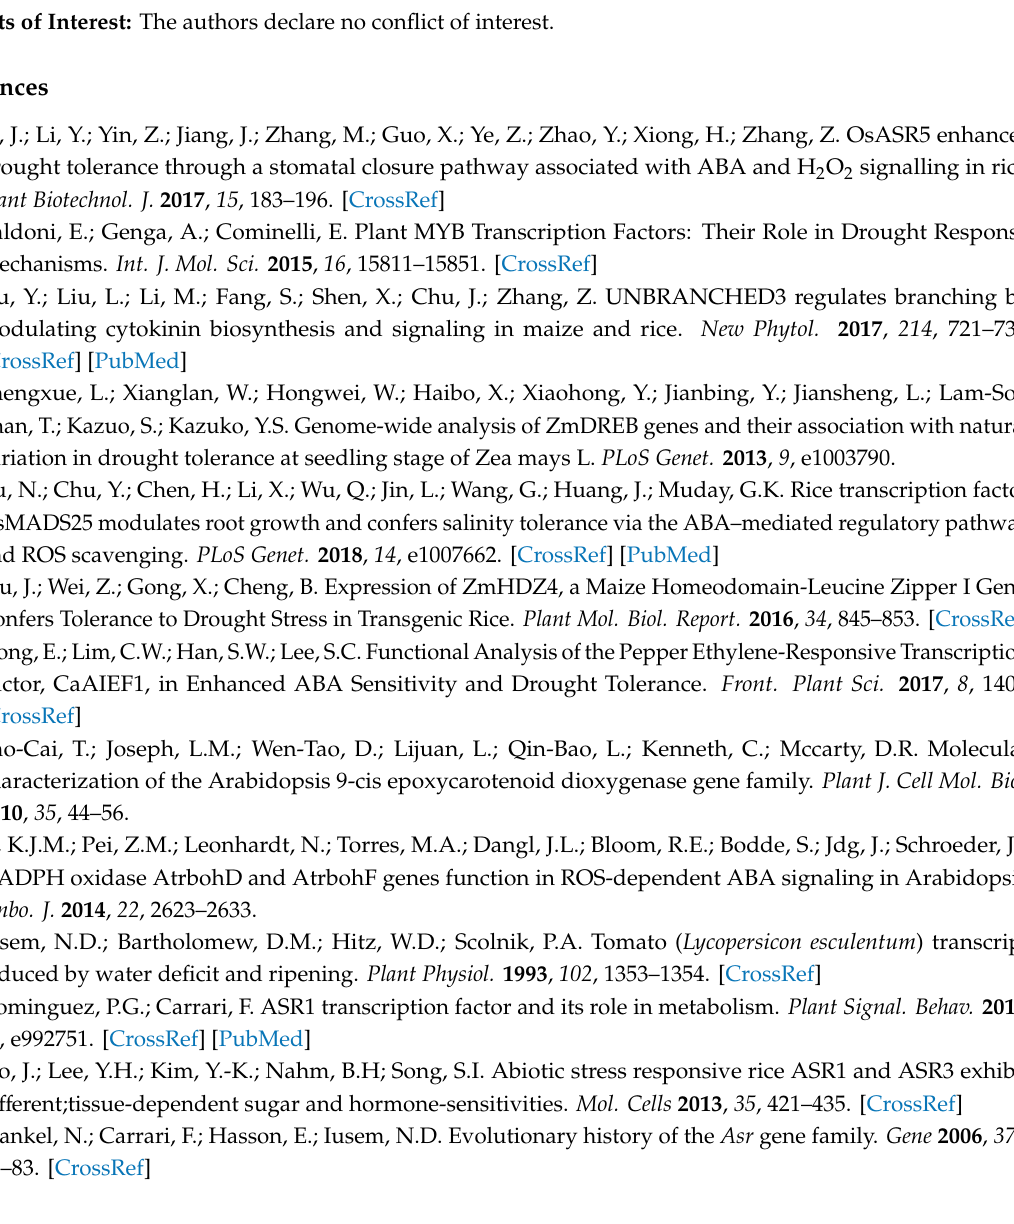
s1. Table S1. The molecular features of ASR genes. Table S2. Primer sequences in this study. Figure S1. ZmASR3 and ZmASR4 can form a homodimer in yeast. Figure S2. Expression analysis of ZmASRs in transgenic Arabidopsis assessed by qRT-PCR. Figure S3. Photographs and measurements of root lengths of WT and ZmASR transgenic seedlings at the post-germination stage on half MS with di ff erent mannitol and ABA concentrations. Figure S4. Analysis of POD activity of the three ZmASR3 transgenic lines and WT plants. Figure S5. ABA sensitivity analysis in ZmASR3 transgenic and WT plants. Figure S6. E ff ects of Tu on ZmASR3 -overexpressing transgenic lines and WT